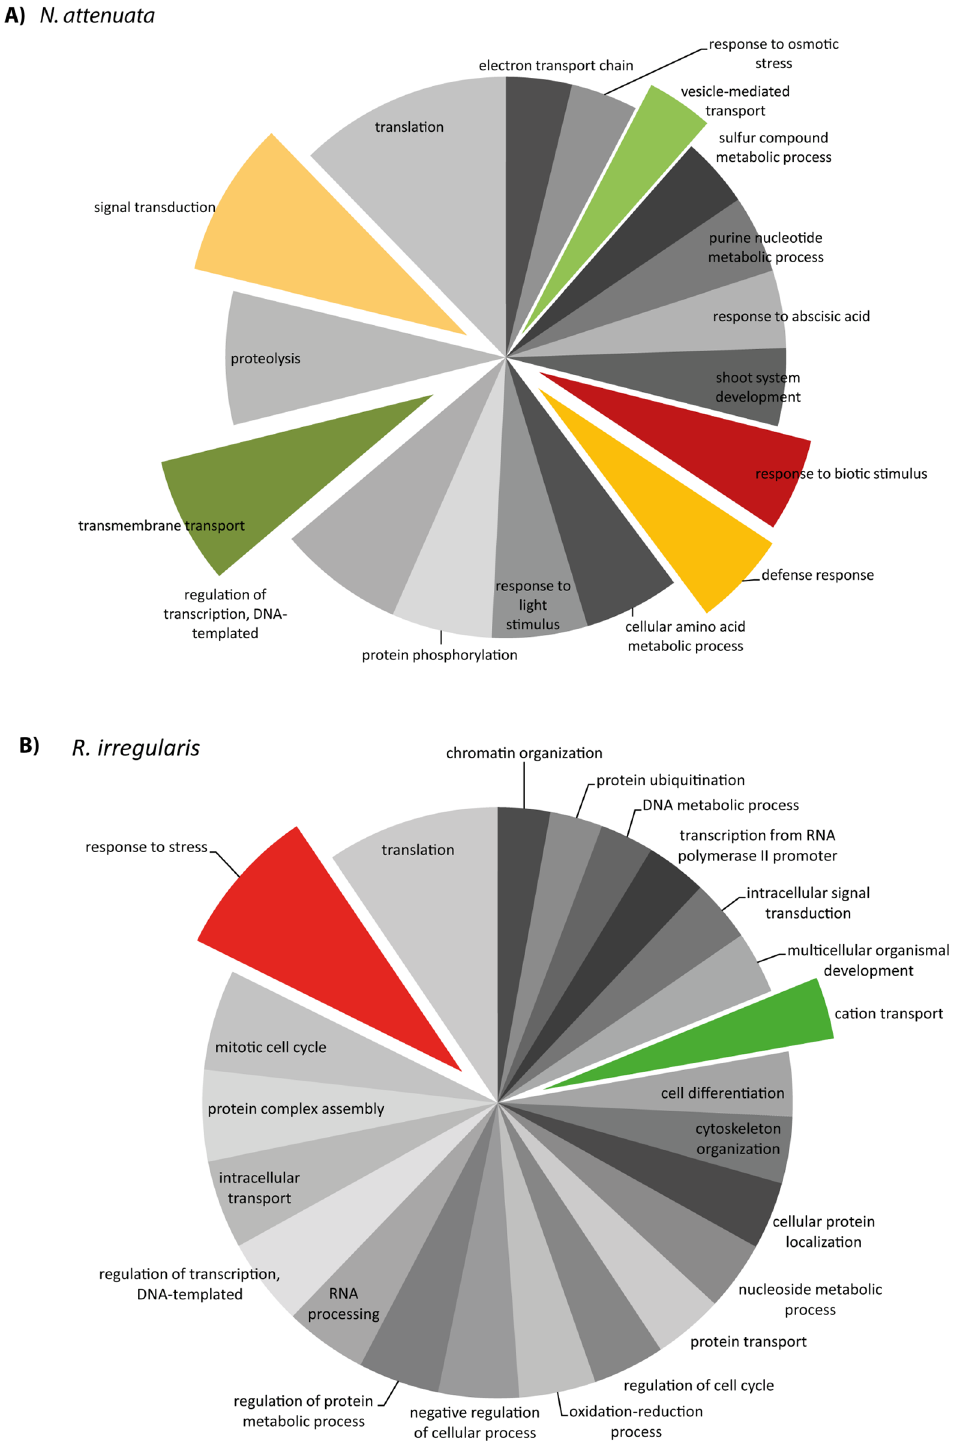
Fig 2. Gene ontology analysis showing node scores based on combined graphs of Tags matching with N . attenuata (A) and R . irregularis (B) genes. The classification of the genes was performed according to the gene ontology term "biological process". Only Tags with a significant (p (cid:1) 0.05) log2 fold change > |2| were considered. The cut-off for node scores is